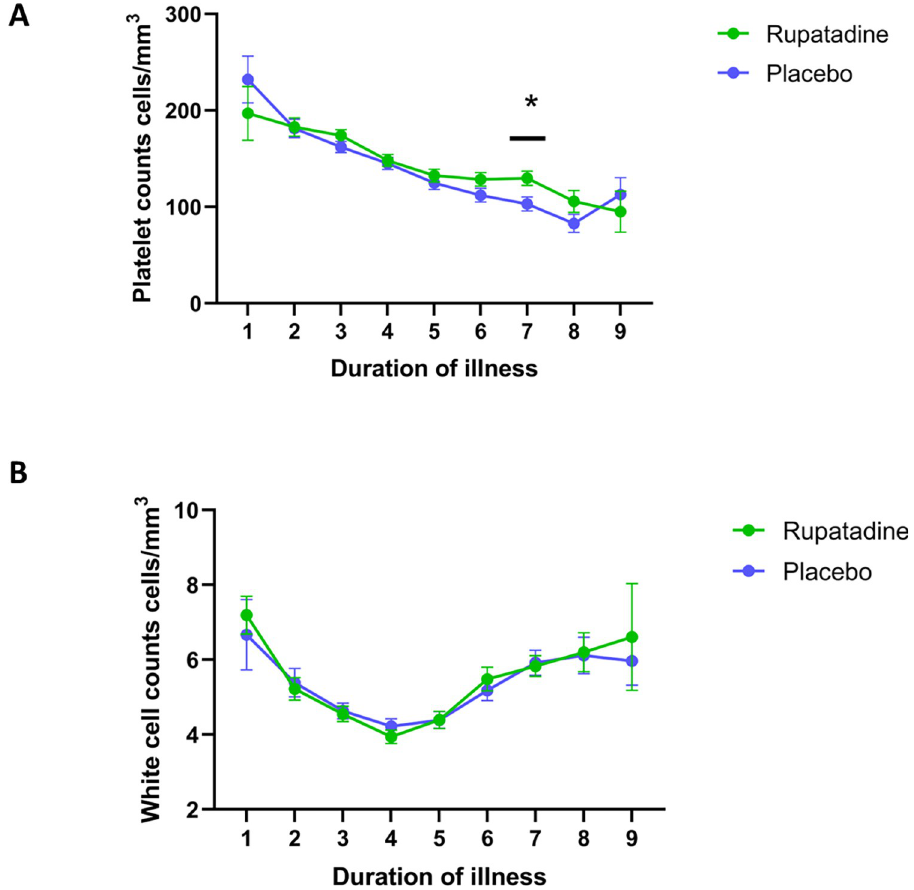
Fig 2. The change in the platelet counts and white cell counts in patients with acute dengue infection. Platelet counts were measured daily in patients with acute dengue infection who were on rupatadine 40mg daily (n = 123) or a placebo daily (n = 126). Data shown for day 9 includes only 6 patients on rupatadine and 7 patients on the placebo as many recovered and were not followed up until this time (A). Total white cell counts were also measured daily in patients with acute dengue infection who were on rupatadine 40mg daily (n = 123) or a placebo daily (n = 126) (B). Differences the two arms of treatment were done using multiple unpaired non-parametric t tests. The lines indicate the mean and the error bars the standard error of the mean. All tests were